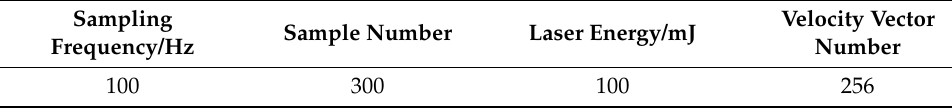
PIV results Numerical results Figure 5. Comparison of calculation and PIV experiment results.